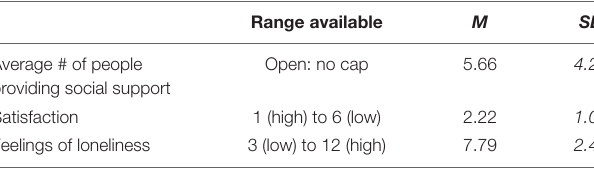
TABLE 2 | Social support and loneliness.